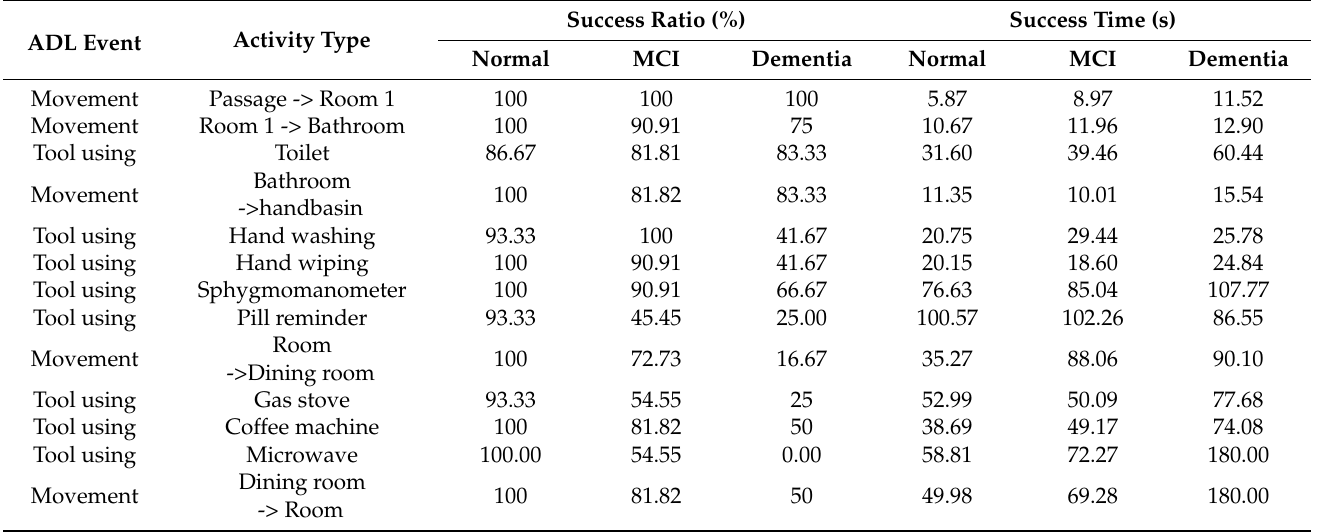
Table 4. Test Result of ADL Diagnosing System.